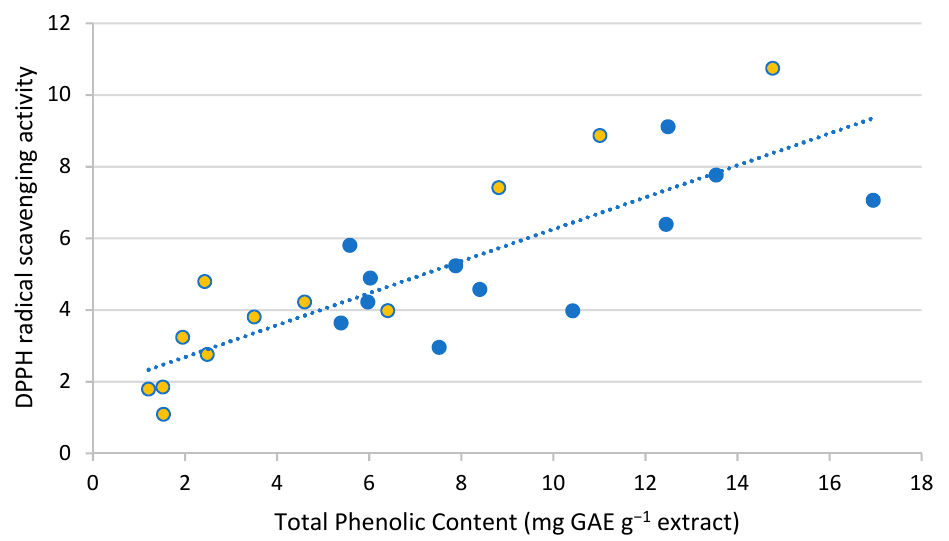
Figure 5. Linear correlation between the total polyphenolic content (mg of GAE g − 1 extract) and DPPH antioxidant activity. Scatter plot diagram illustrating the correlation using ethanol (orange) or water (blue) as solvent. Table 2. Antimicrobial activity of G. gracilis ethanolic fractions obtained after 30 min extraction at room temperature and chloramphenicol (CHL) against several fish pathogenic bacteria strains. The results are expressed as mean diameter of inhibition halos (mm) ± standard deviation ( n =